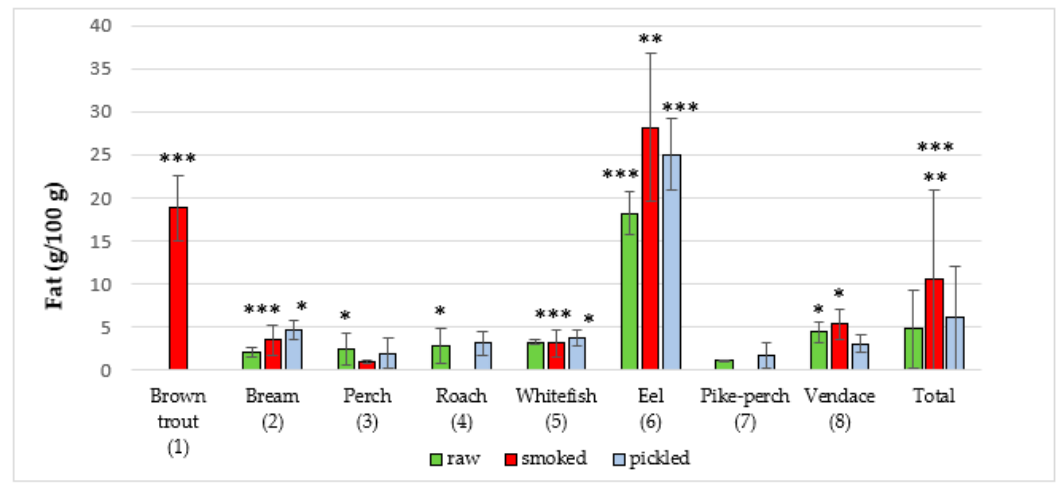
Figure 2. Fat content in raw ( R ), smoked ( S ) and pickled ( P ) fish products samples (g/100 g). The statistical analysis has shown significant differences of content of fat between species in R, S and P groups of freshwater fish products (*** p < 0.001, ** p < 0.01, * p < 0.05). R: p < 0.05, (3 vs. 7), (4 vs. 7), (8 vs. 1, 2, 3, 4, 5, 7); p < 0.001, (6 vs. 1, 2, 3, 4, 5, 7, 8); S: p < 0.05, (8 vs. 2, 3, 5); p < 0.01, (6 vs. 1, 2, 3, 5, 8); p < 0.001, (1 vs. 2, 3, 5, 8), (2 vs. 3) and (5 vs. 3); P: p < 0.05, (2 vs. 3, 4, 5, 7, 8) and (5 vs. 3, 7); p < 0.001, (6 vs. 2, 3, 4, 5, 7, 8); Total : p < 0.01, (S vs. P); p < 0.001, (S vs. R).